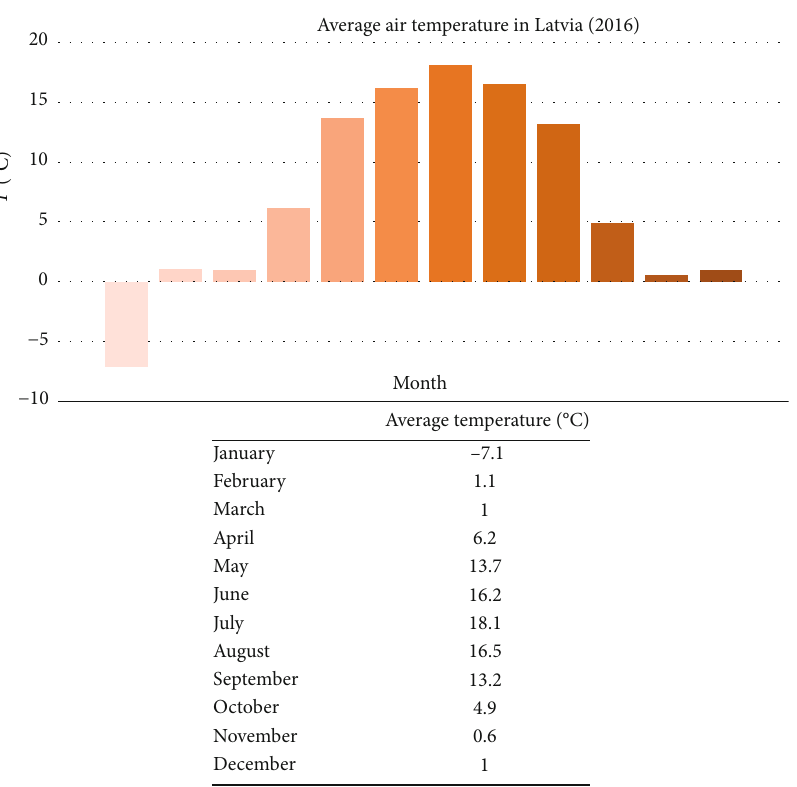
Figure 1: Average air temperature in Latvia (in